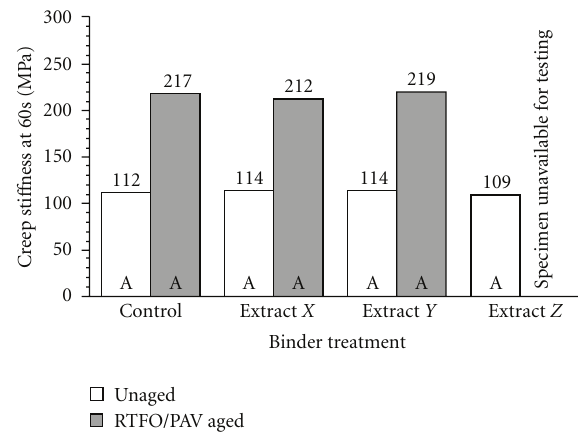
Figure 12: Creep sti ff ness of original and PAV aged control binder and binder with finish extracts tested at − 12 ◦ C. Statistical compar- isons were made within each stage of